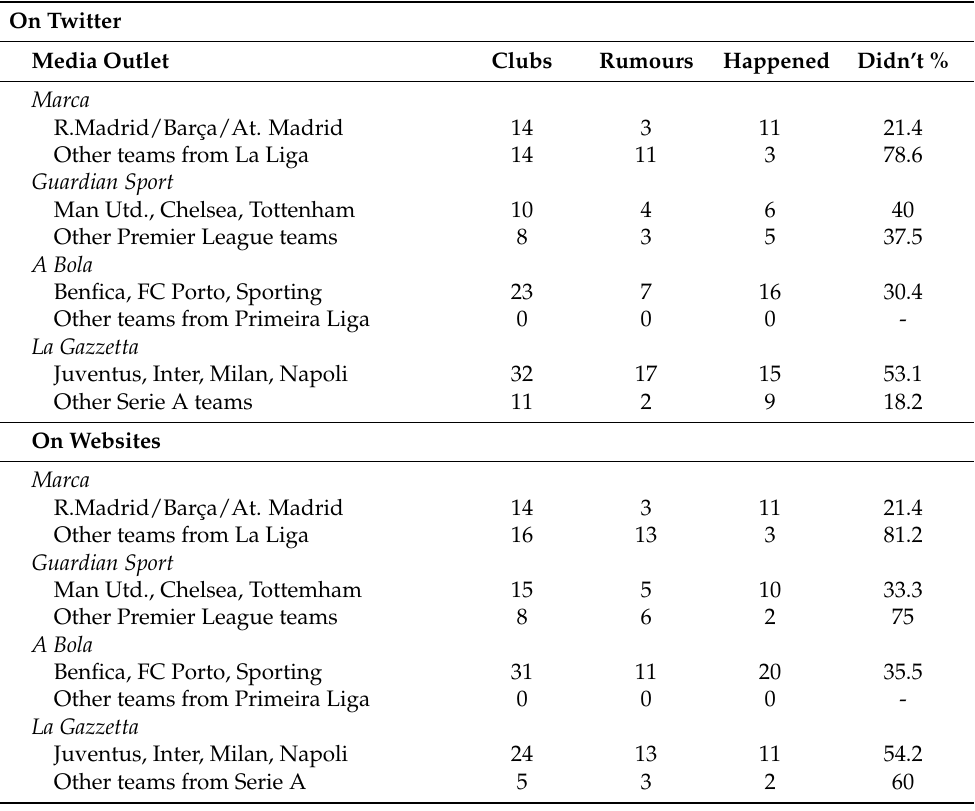
Table 6. The table shows rumours that finally happened or not regarding clubs